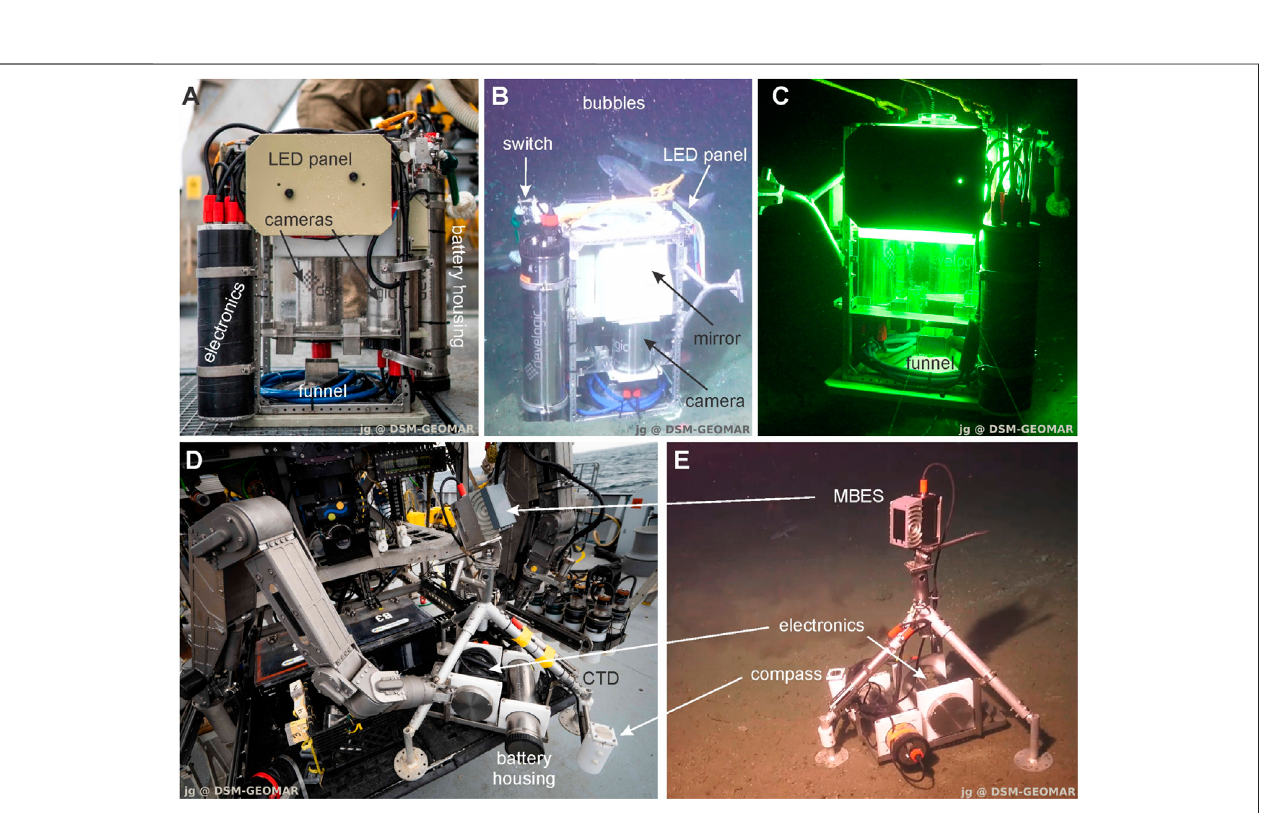
FIGURE 2 | BBox on deck (A) , on the sea fl oor (B) , and turned on with fl ushing LEDs (C) . Shown are the different components. In (B,C) , bubbles can be seen escapingtheBBoxonthe top;C alsoshows bubble within theBBox. GasQuant IIlander systembeforedeploymenton theROV (D) and locatedon thesea fl oor (E) with main parts of the system